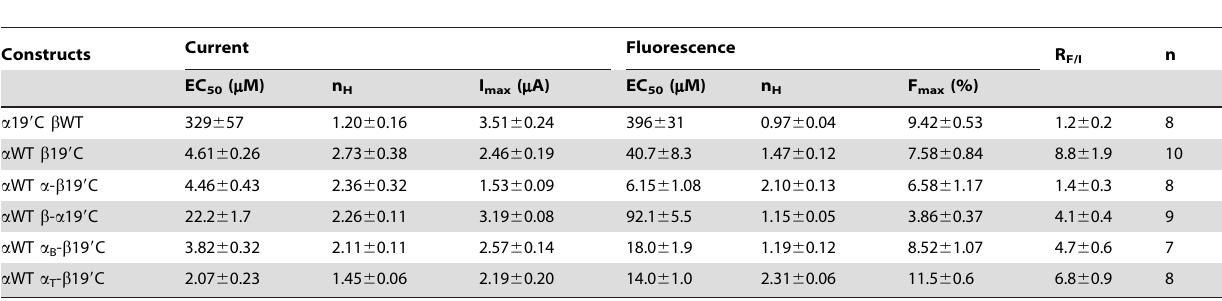
Table 2. Properties of glycine induced currents and fluorescences of MTSR-labeled GlyRs recorded in oocytes.